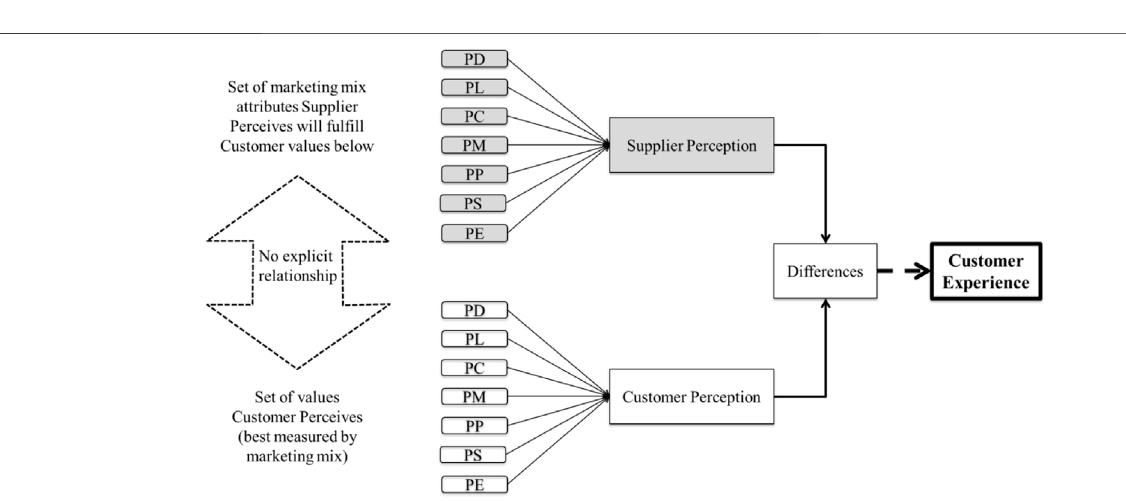
Frontiers in Built Environment |